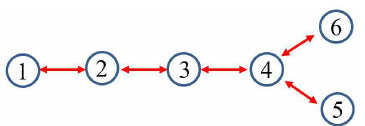
Figure 11. The communication scheme related to the partitioned IEEE 118-bus system.